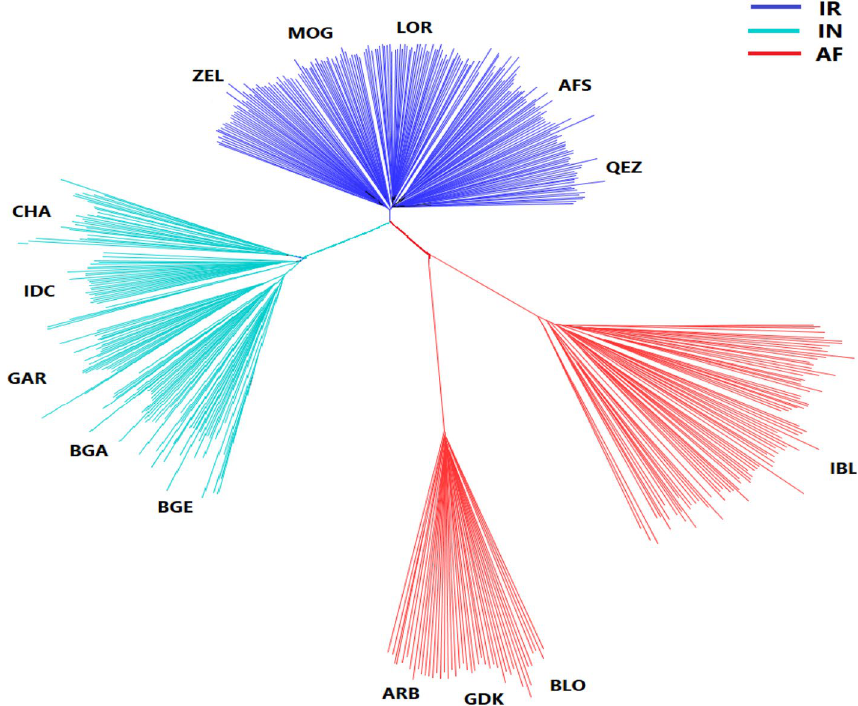
Figure 1. Neighbor-joining phylogenetic tree for 14 sheep breeds based on autosomal SNPs. For breed abbreviations, see Table